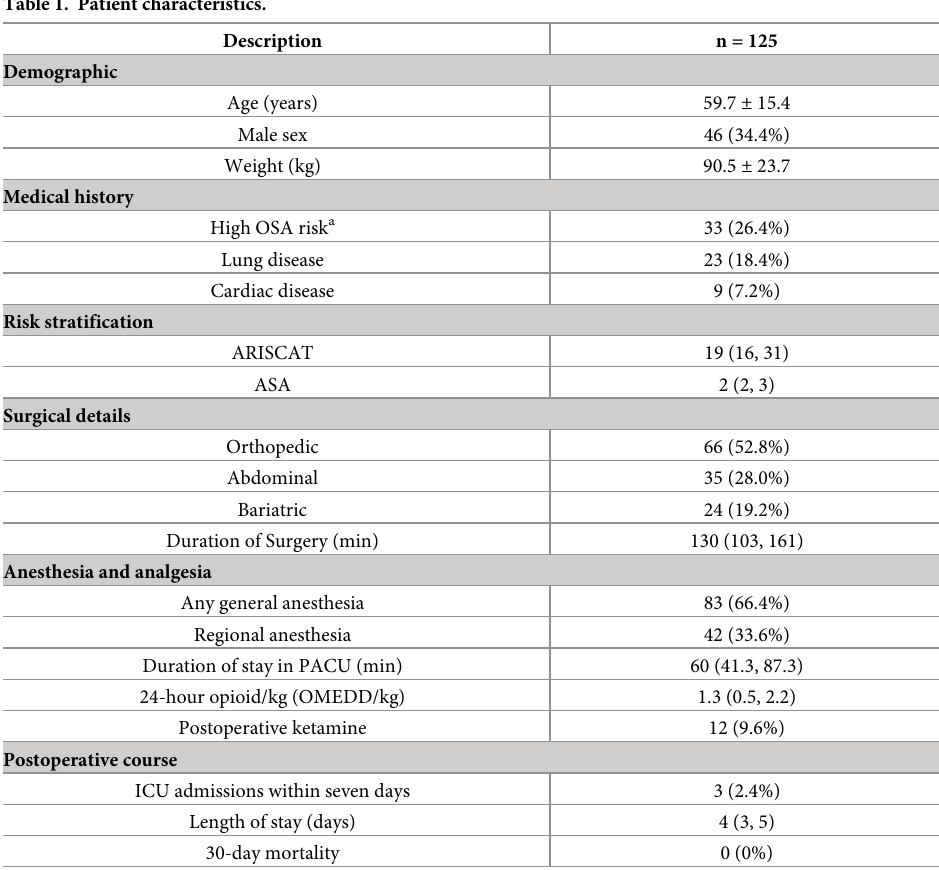
Table 1. Patient